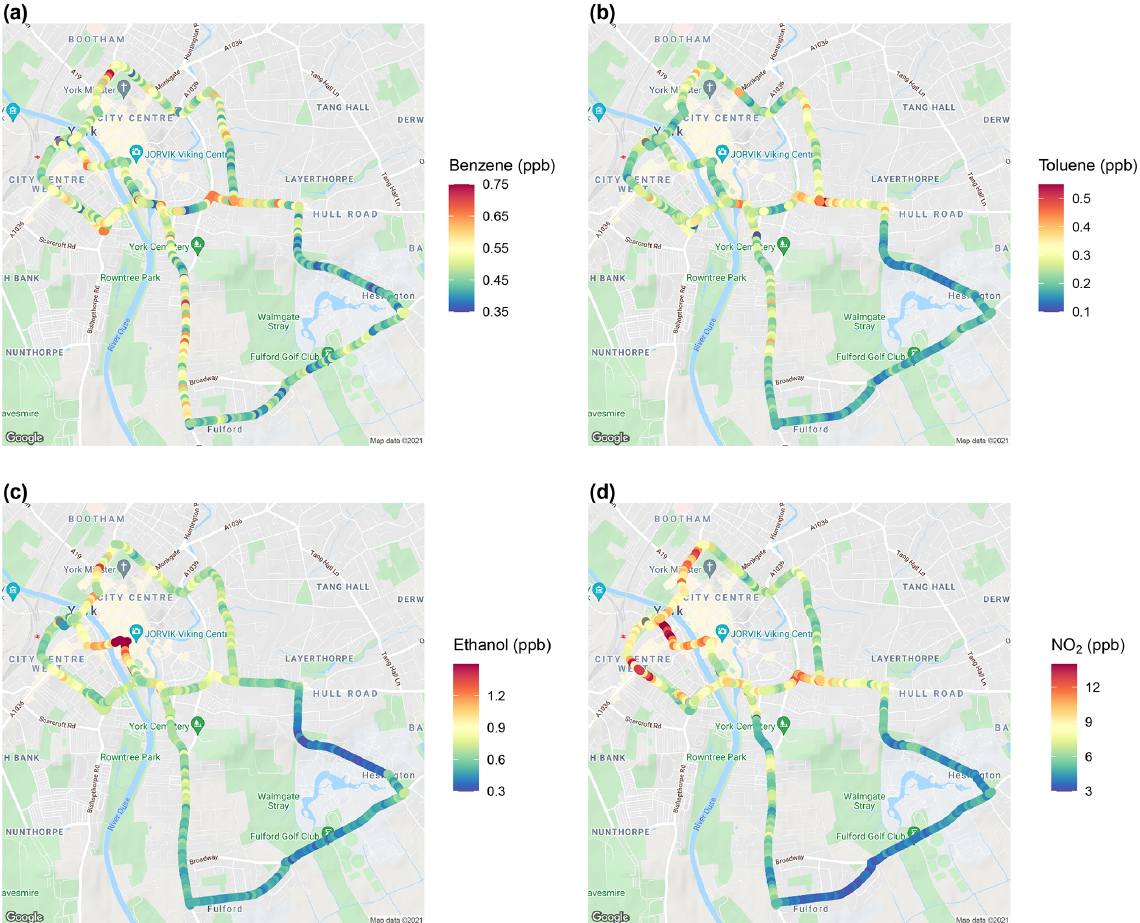
Figure 7. Spatial mapping of median values of (a) benzene (ppb), (b) toluene (ppb), (c) ethanol (ppb) and (d) NO 2 (ppb) from mobile measurements around York (© Google). Visualised by the ggmap R package (Kahle and Wickham,